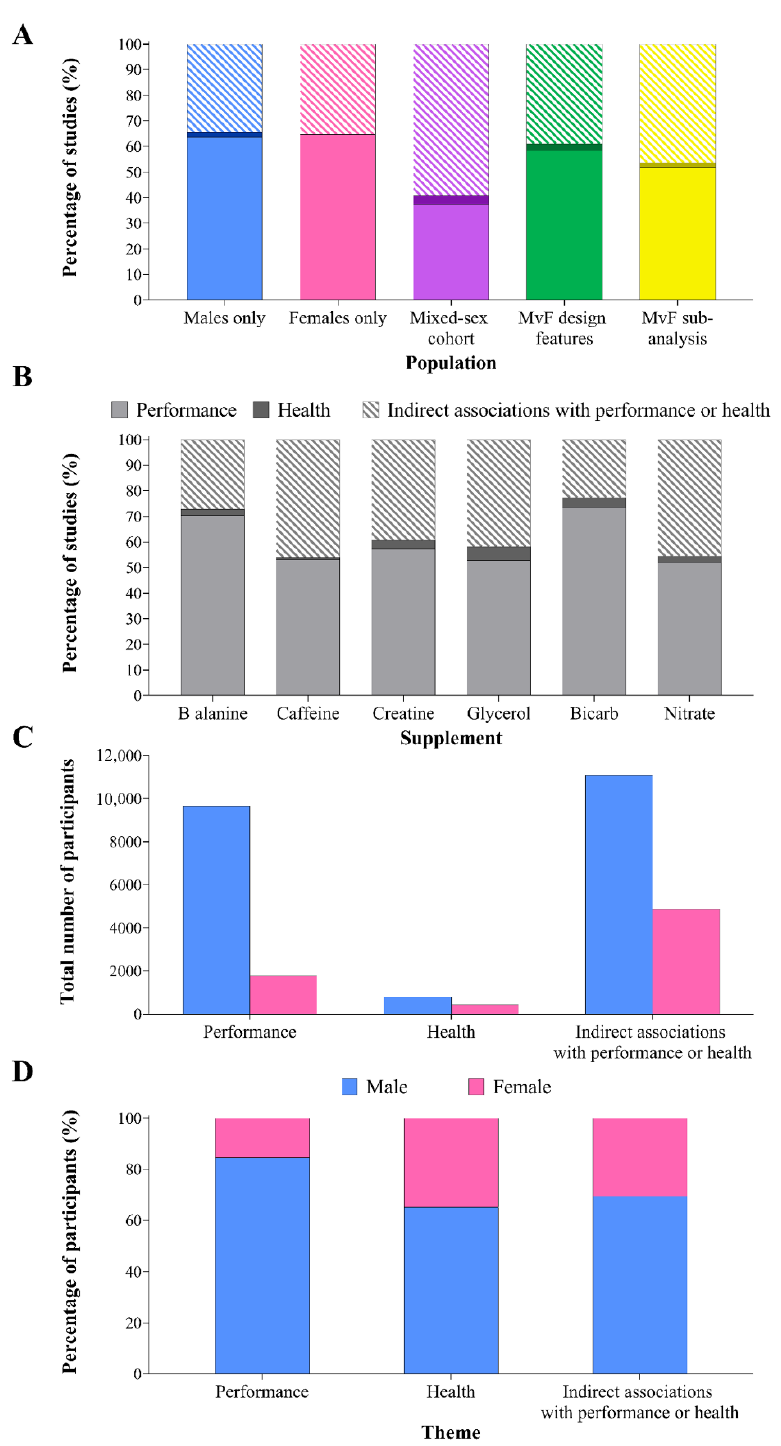
Figure 6. Percentage of studies in each theme, separated by ( A ) population (colours correspond to those used in Figure 3A) and ( B ) performance supplement. Number of participants represented as the ( C ) absolute number and ( D ) percentage of the total participants in each theme: performance (direct performance outcomes), health (outcomes related to health status/condition) and indirect associations with performance/health (a physiological or psychological adaptation/response that may subsequently transfer to athletic performance/health). Male versus female (MvF).